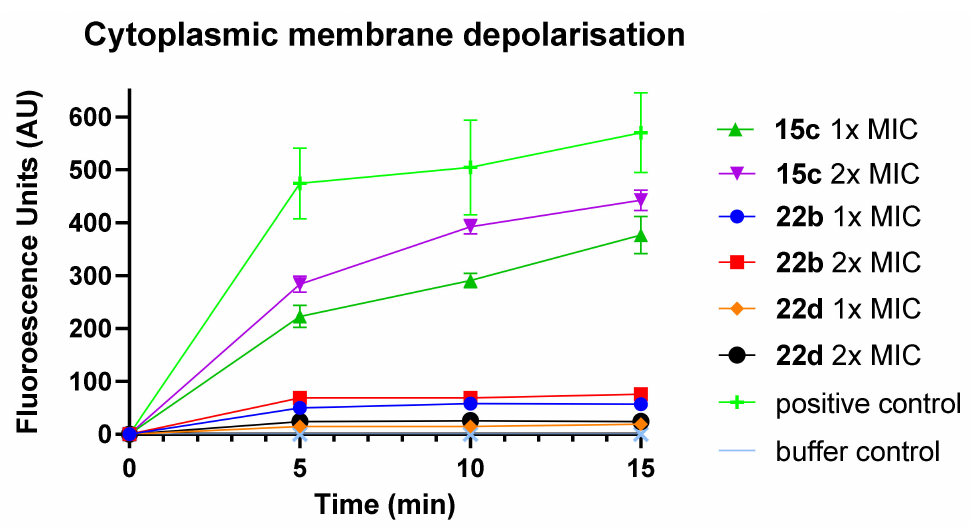
Figure 5. Cytoplasmic membrane disruption of S. aureus promoted by compounds 15c, 22b and 22d at 1 × and 2 × of their MIC. 10% DMSO was used as positive control.